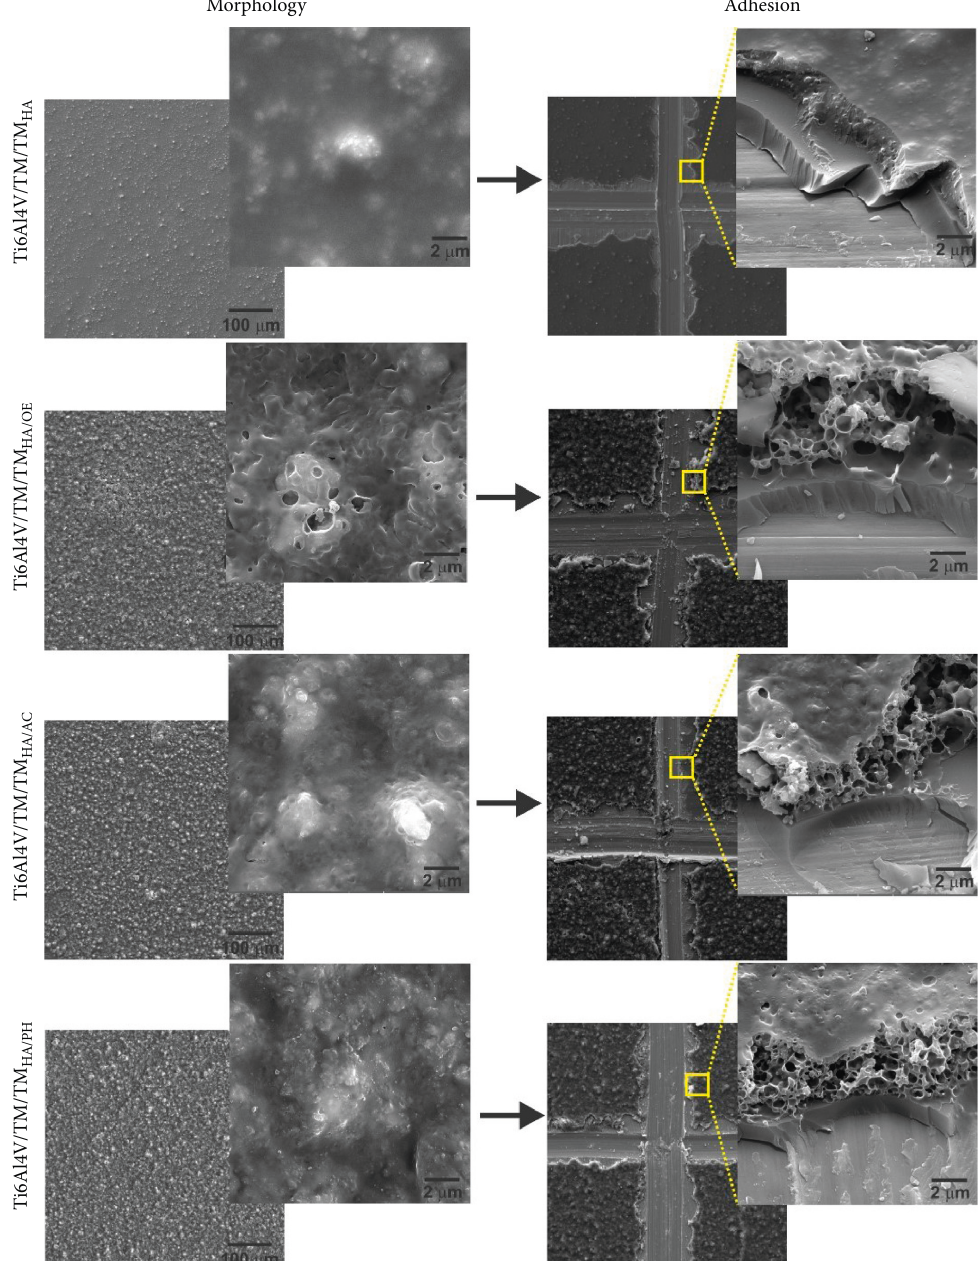
Figure 4: SEM/FEG micrographs of the nonsterilized and the sterilized (by three different processes) hybrid coatings before and after the adhesion test on the protective